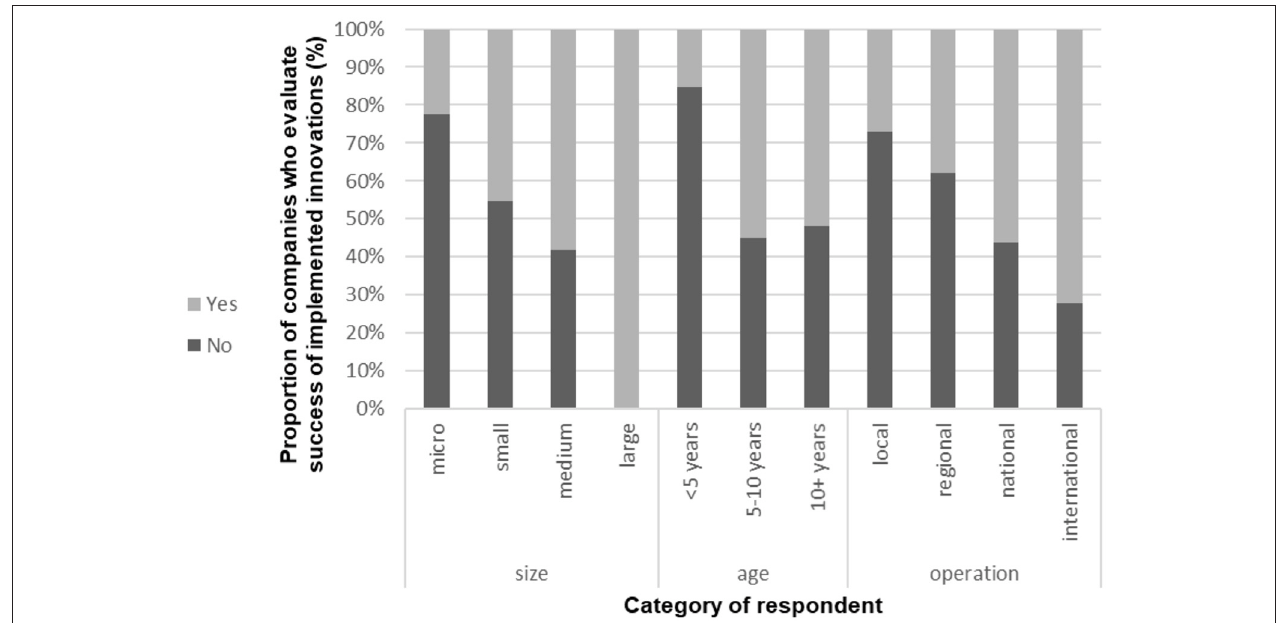
FIGURE 2 | Evaluation of successful